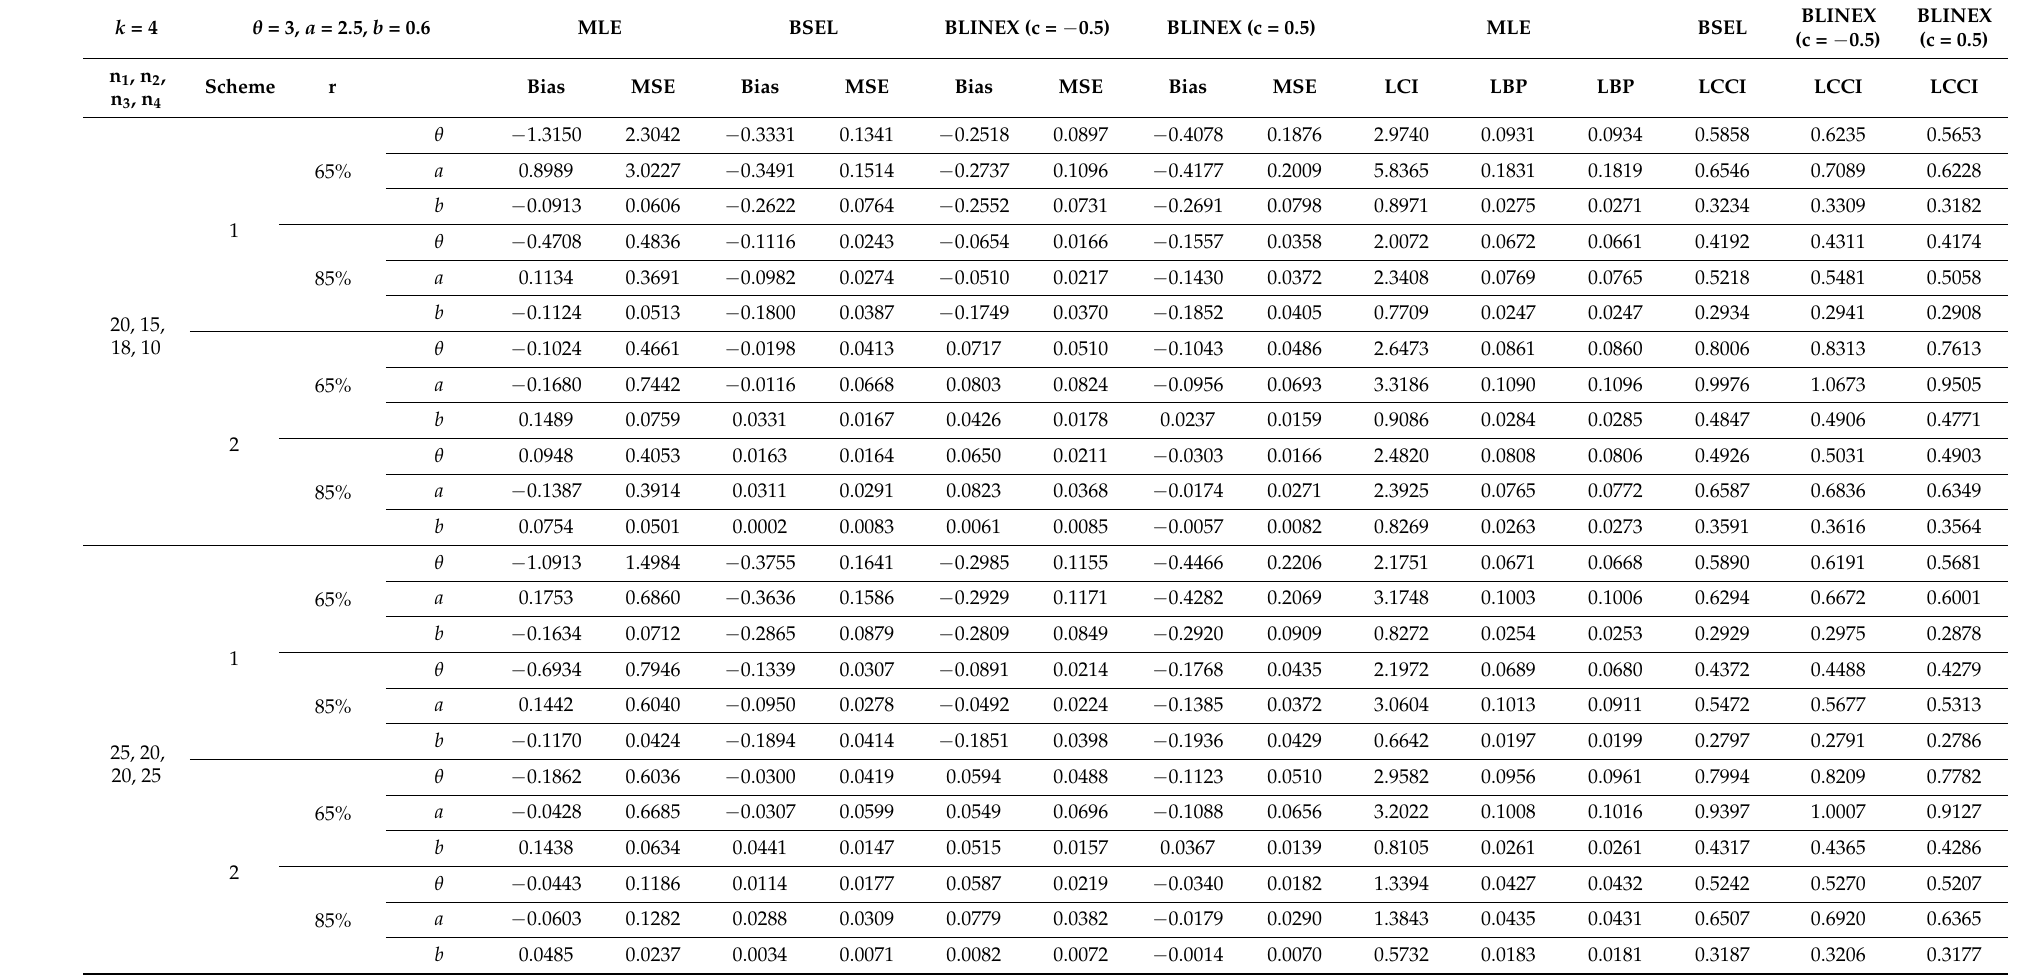
Table 6. MLE and Bayesian estimation with different loss functions in multi ramp when θ = 3, a = 2.5, b = 0.6. k = 4 θ = 3, a = 2.5, b =